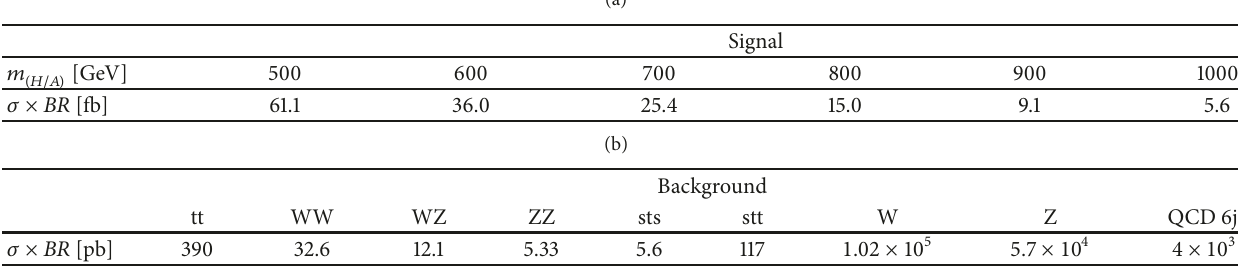
Table 2: The signal and background cross sections at √𝑠 = 14 TeV.The “sts” and “stt” denote the 𝑠 -channeland 𝑡 -channelsingle top processes and QCD 6j represents QCD multijet events with 6 jets in the final state.